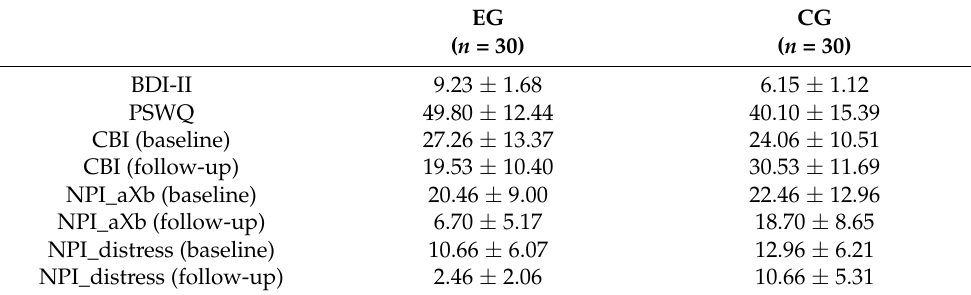
Table 1. Clinical measures of the EG and the CG prior and after the intervention.